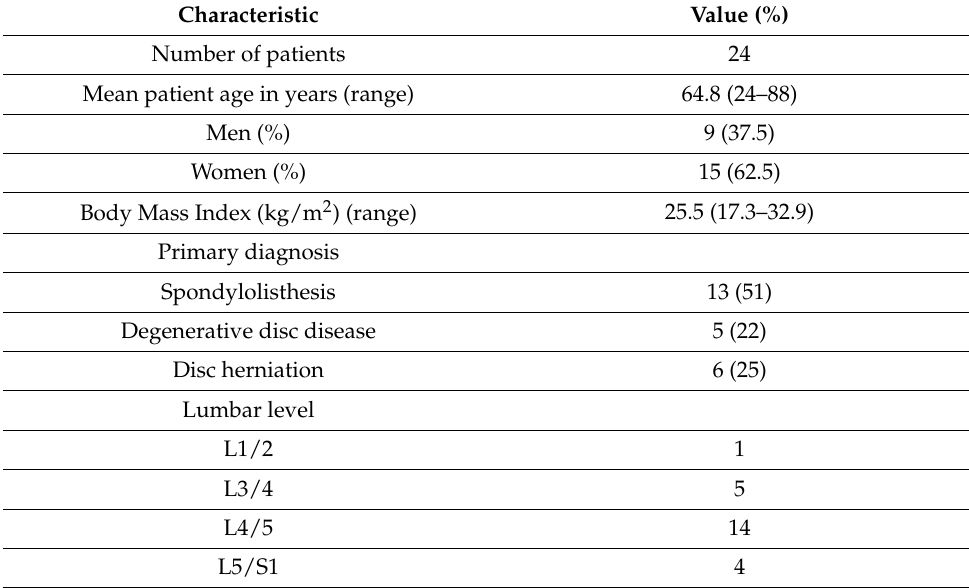
Table 1. Patient demographic and treatment information.